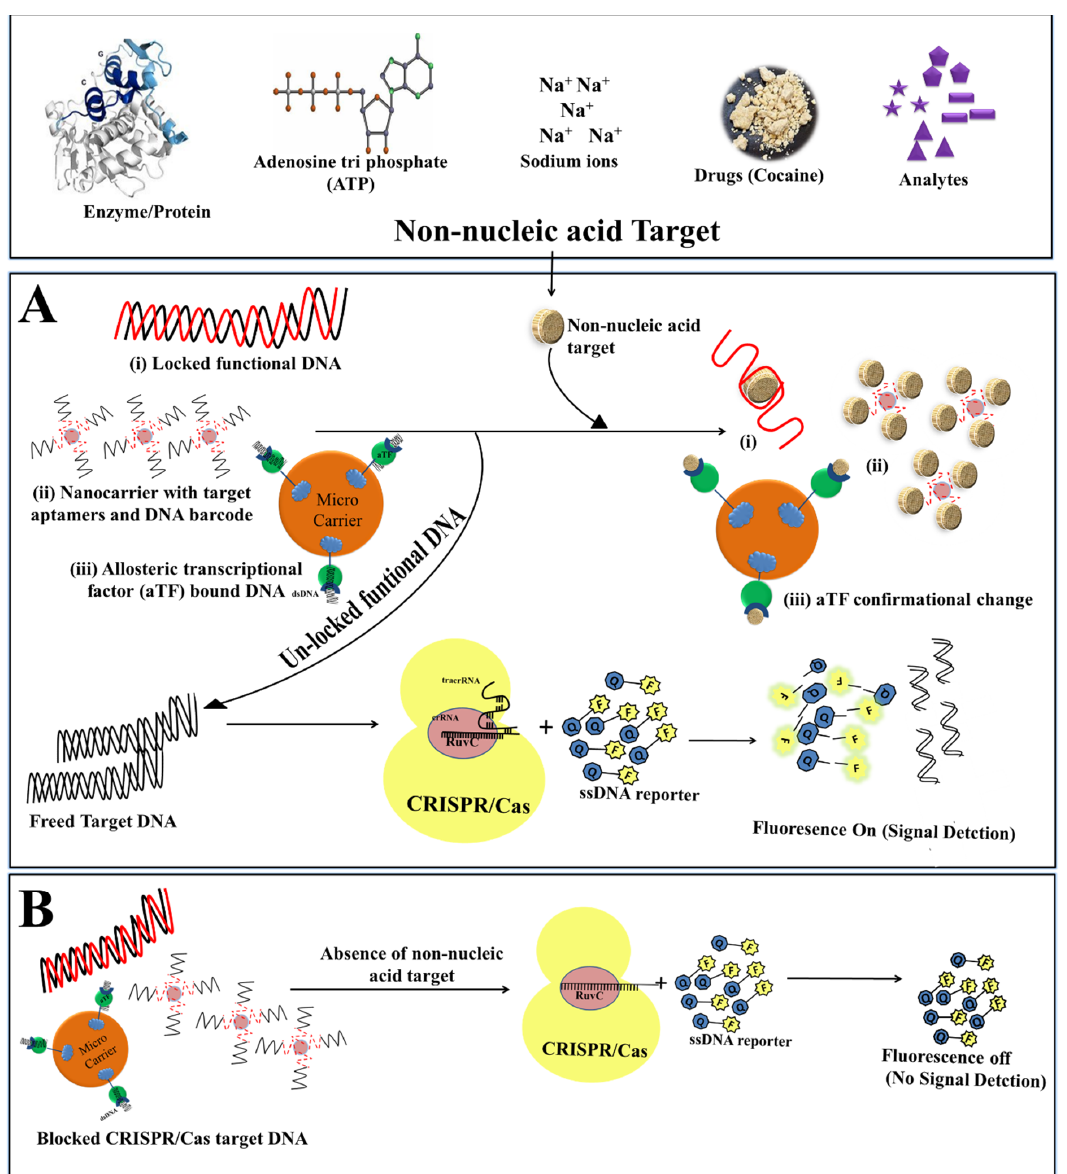
Figure 6. CRISPR/Cas based bio ‐ sensing mechanism for non ‐ nucleic acid targets (NNTs). ( A ) Bio ‐ sensing mechanism of CRISPR/Cas system in the presence of NNTs. The binding of NNTs to allosteric transcriptional factors brings about conformational changes and releases the locked target DNA, which activates CRISPR/Cas endonuclease. This activates the collateral cleavage activity of the CRISPR/Cas system and chop ‐ off the reporter DNA to produce the signal. ( B ) The absence of target NNTs does not trigger the release of target DNA hence no signal generates.